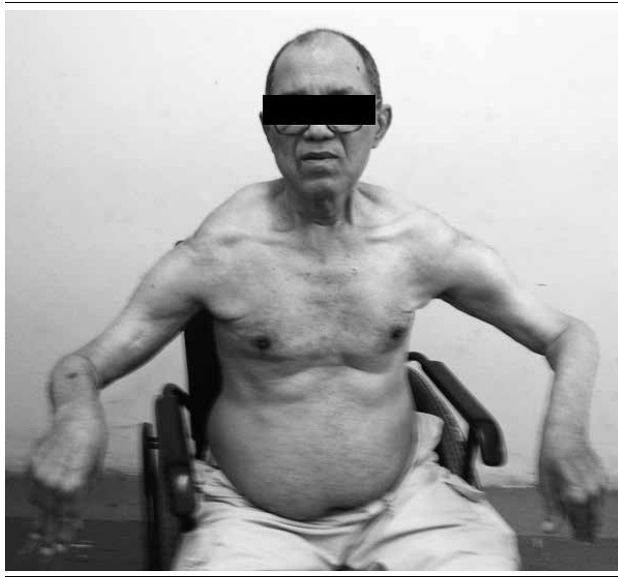
figurE 1 – Marked muscle atrophy in the upper limbs in a patient with IBM IBM: inclusion-body